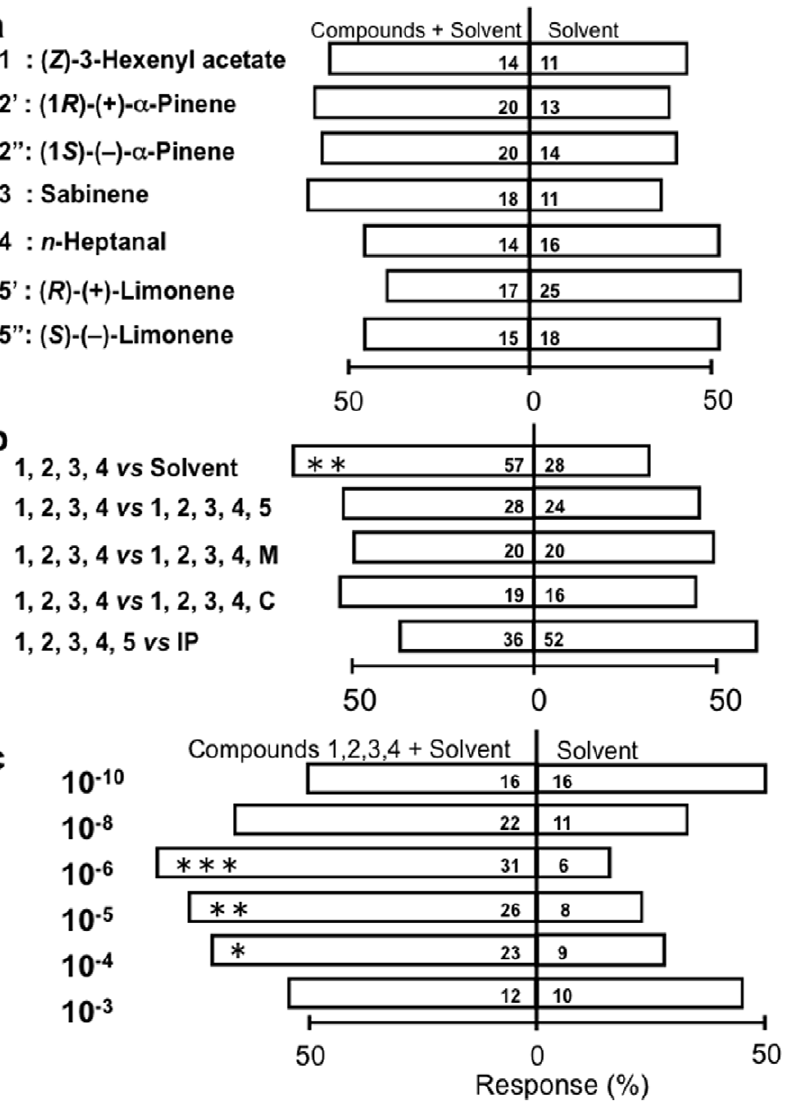
Figure 5. Response of parasitoid Cotesiavestalis to synthetic volatiles. Choice of parasitoid when offered (5a) pure, (5b) mixed (pure sabinene, n -heptanal, a -pinene and ( Z )-3-hexenyl acetate in a ratio of 1.8:1.3:2.0:3.0) and (5c) a dilution series of mixed synthetic volatiles against the solvent (in 5abc) or the complete blend emitted from DBM-infested cabbage plants (only in 5b). Within each bar expressing response percentage, two numbers refer to totals of parasitoids, that visited respectively the + plant and the – plant offered in the test and asterisks refer to significance level according to replicated G -tests (* 0.01 , P # 0.05; ** 0.001 , P # 0.01; *** P # 0.001). Results per replicate and from replicated G-tests are shown in Tables S7, S8 and S9. Pure and mixed chemicals dissolved in hexane (0.01 mg /compound/ ml hexane) (5a, 5b) or diluted in TEC (5c; dilution factor at left-hand side) are indicated by rank numbers attributed in Figure 3b or by capital letters, where M= myrcene, C= camphor represent two arbitrary additional compounds and the notation IP refers to a DBM-infested plant. Note that emission at 10 2 6 dilution in TEC approximates that from the hexane solution used in Figure 5b.